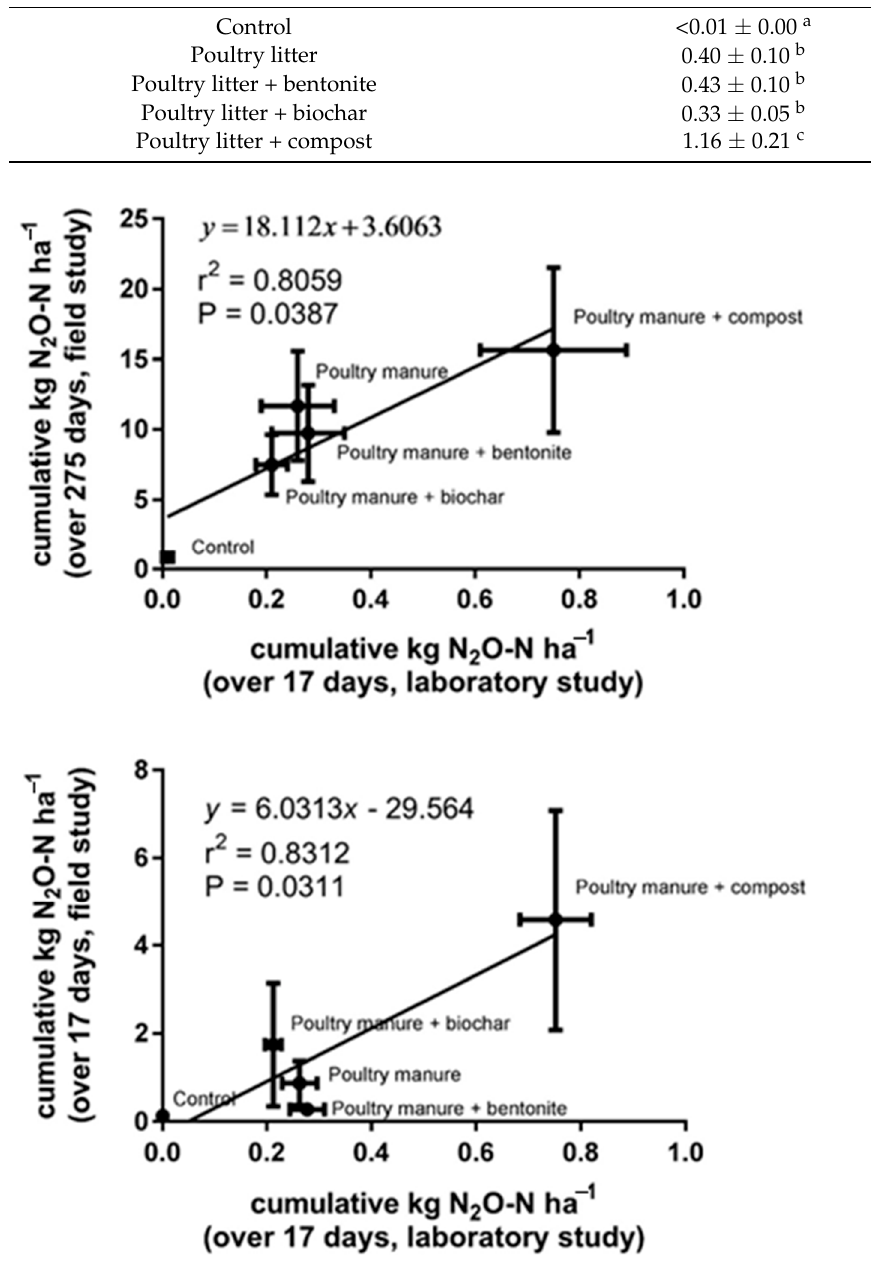
Figure 6. Comparison between cumulative field N 2 O emission estimates and in vitro laboratory incubations. Top pane relates to the entire field trial (y axis), while bottom pane compares results from the first 17 days of field and laboratory experimentation.